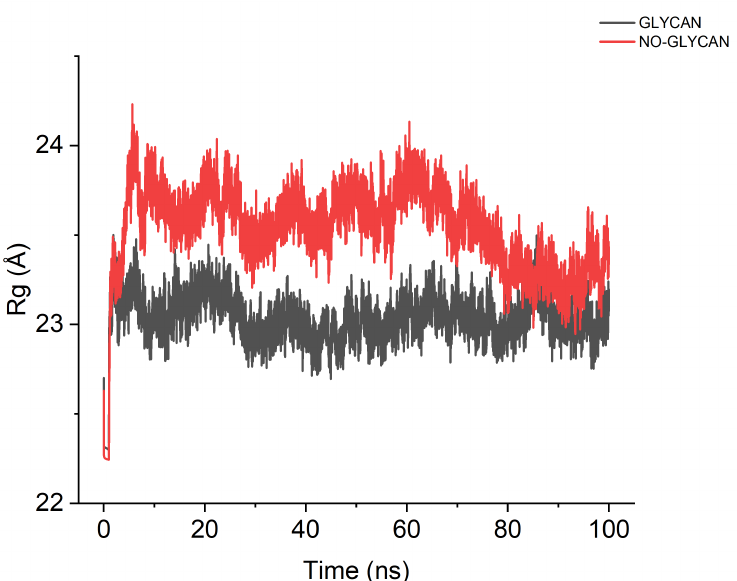
Figure 6. Calculation of the radius of rotation. The black curve is GLYCAN; the red curve is NO- GLYCAN.